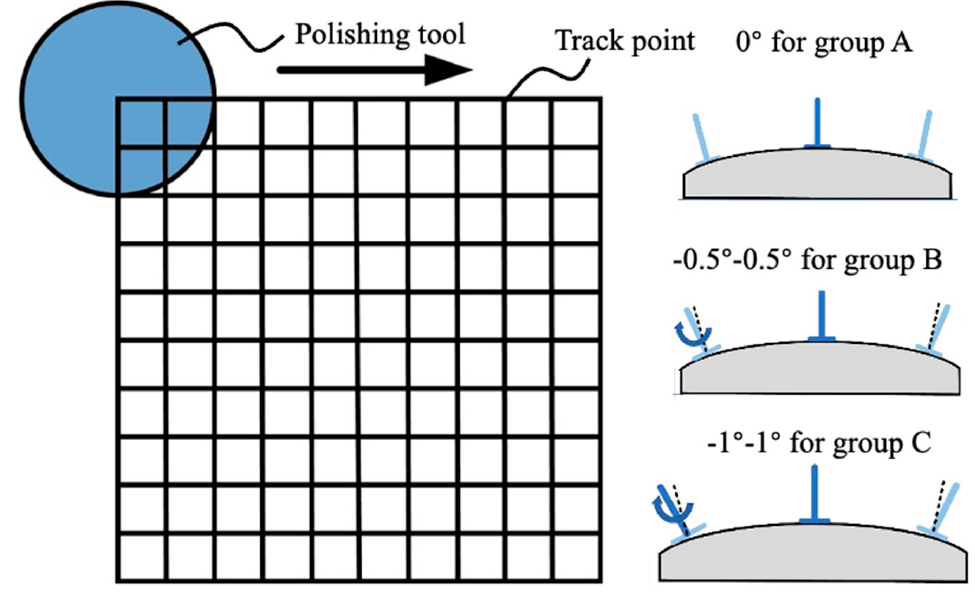
Figure 4. Discretization of polishing path and illustration of tool normal error for corresponding machining tracks.